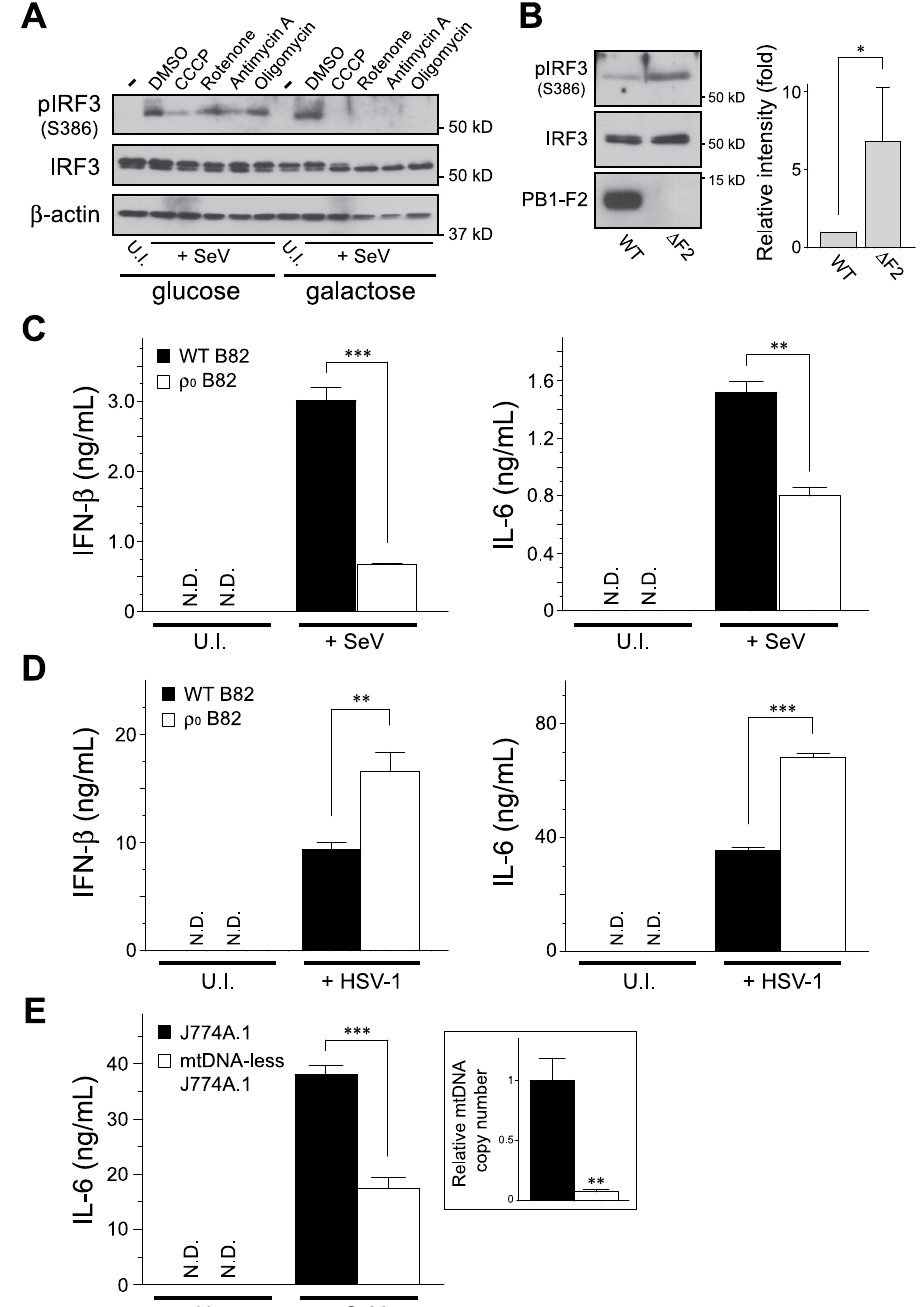
Figure 3. OXPHOS activity couples with the RLR pathway to execute antiviral signal transduction. ( A ) HEK293 cells cultured in glycolytic or oxidative media were infected with SeV (4 HAU/mL) for 2.5 h, and the infected cells were further incubated with the indicated mitochondrial inhibitors for 2.5 h (total 5 h infection). The activation of endogenous IRF-3 was analyzed by Western blotting with antibodies against the specific antibody (pIRF-3; Ser386). Anti- β -actin was used as the loading control. U.I., uninfected. ( B ) Comparison of the IRF-3 activation between cells infected with recombinant influenza A/PR8 viruses ( WT versus Δ F2 , each used 2 HAU/mL) cultured under oxidative conditions. The Δ F2 strain is a mutant strain with genetic removal of the PB1 - F2 gene from the viral genome 21 . The graph on the right shows the quantification of pIRF-3 bands analyzed by densitometry. Error bars indicate SD ( n = 3; Unpaired t -test; * P < 0.05). ( C , D ) The B82 WT cybrids and ρ 0 cells were infected with ( C ) SeV (4 HAU/mL) for 18 h or ( D ) HSV-1 (1 × 10 5 PFU) for 24 h, and the cell-free supernatants were analyzed by ELISA to measure the secreted amounts of IFN- β (left panel) and IL-6 (right panel), respectively. Error bars indicate SD ( n = 3; Unpaired t -test; ** P < 0.01 and *** P < 0.001, respectively). U.I., uninfected. N.D., not detected. ( E ) Similar to ( C ), except that the mtDNA-less J774A.1 and its parental macrophages were infected with SeV (2 HA units/mL). Inset panel: relative mtDNA copy number was confirmed by qPCR. In ( C – E ), cells were maintained in ρ 0